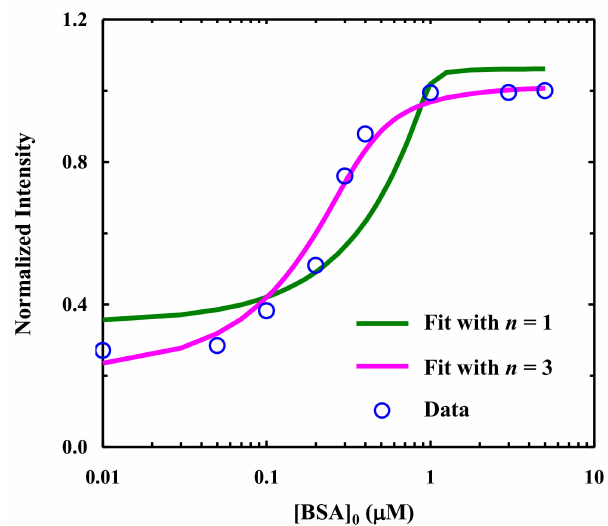
Figure 4. Normalized fluorescence intensity of Oligo1 (1.0 µ M) as a function of the total concentration of BSA (open circles). The solid lines are best fits of these data to Equation (2) with different n values, as indicated. For n = 3, the fit yielded a K d of 125 nM.